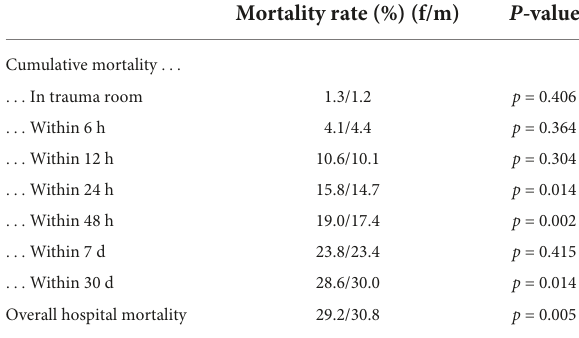
TABLE 4 Mortality rates shown in temporal distribution in the overall study population. Mortality rate (%) (f/m) P -value Cumulative mortality